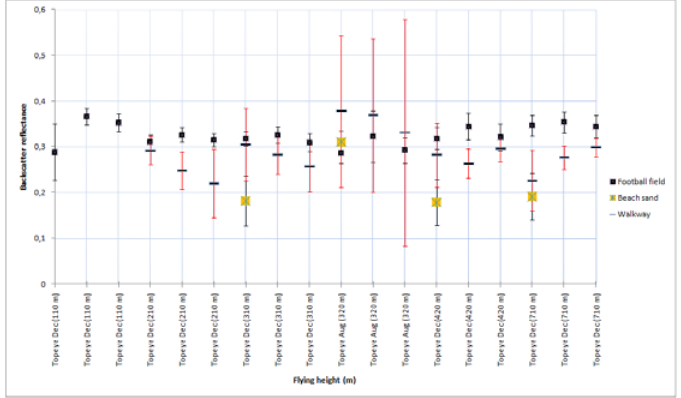
Figure 6A. Backscatter reflectance values calibrated with 45% tarp. The intensity values at 320 m flight altitude are relative to 30% tarp. The standard deviation for the walkway is marked with red color as noticeably large. Data points from heights 110 m, 210 m, 310 m, 460 m and 710 m are from the December 2006 campaign, and data points from height 320 m are from August 2006 campaign. Results for football field, beach sand and